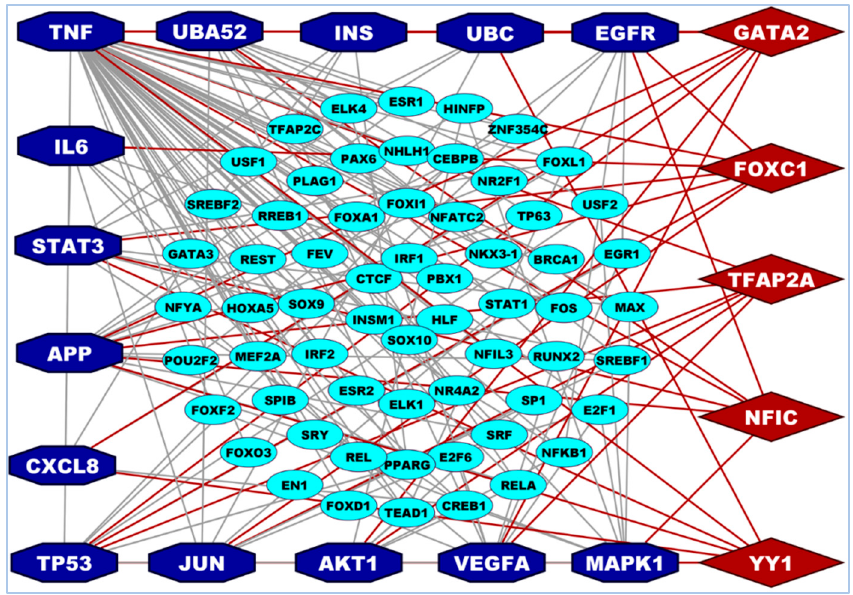
Figure 4. TFs versus hHub-DEGs interaction network that was detected the key regulatory TFs of hHub-DEGs. Here, hHub-DEGs were marked as a blue color with octagon shape in both A and B. The key TFs proteins were marked as a red color with a hexagonal shape and small ellipses represents other